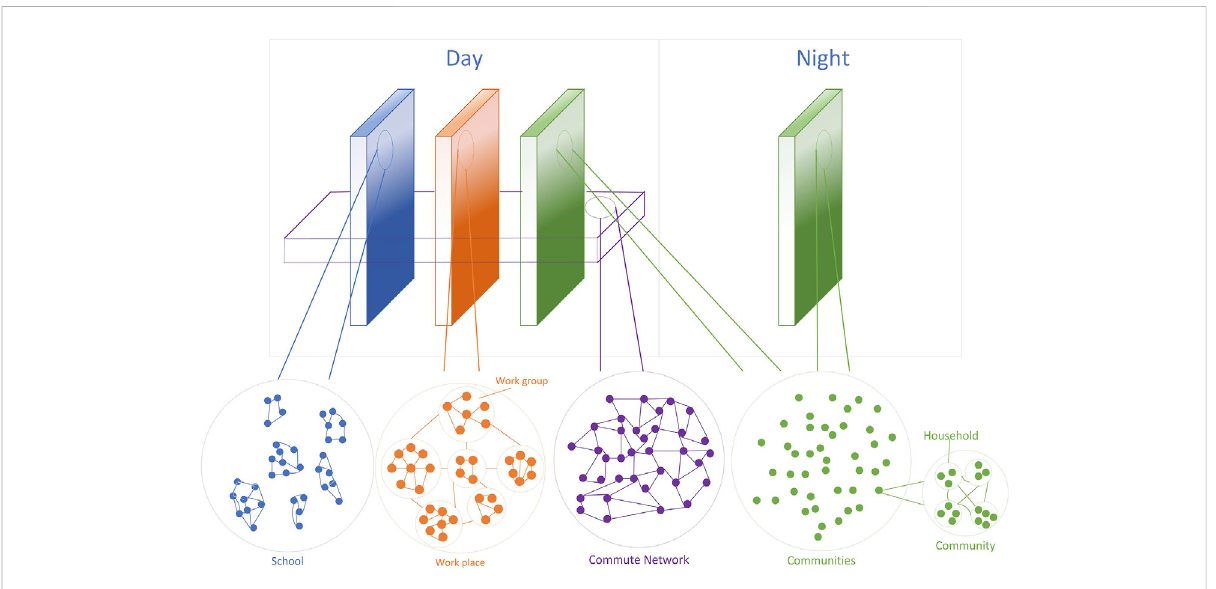
FIGURE 1 Modelstructure.Visualizationofthemulti-layernetwork separatingthedayandnightsocialcontactstructure. Notethatindividuals (thenodes) transit between layers relies on the commute layer, which is interspersed among other